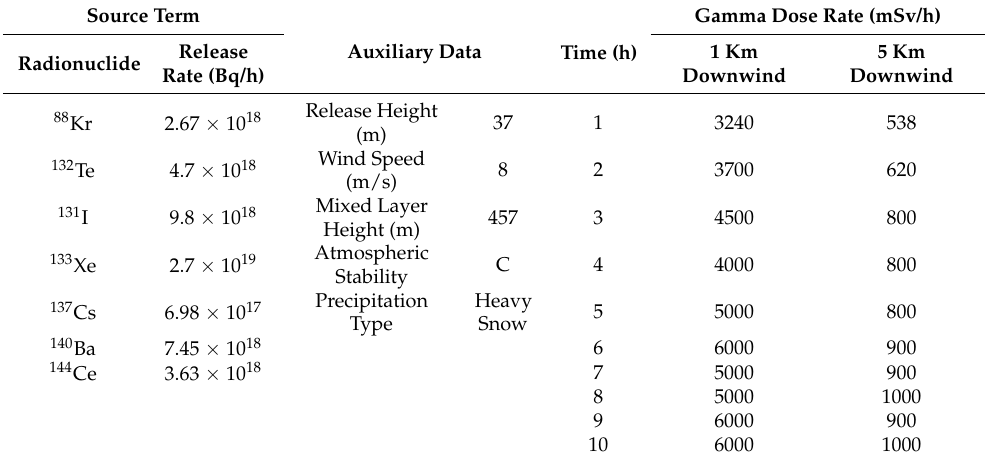
Table 3. A sample data